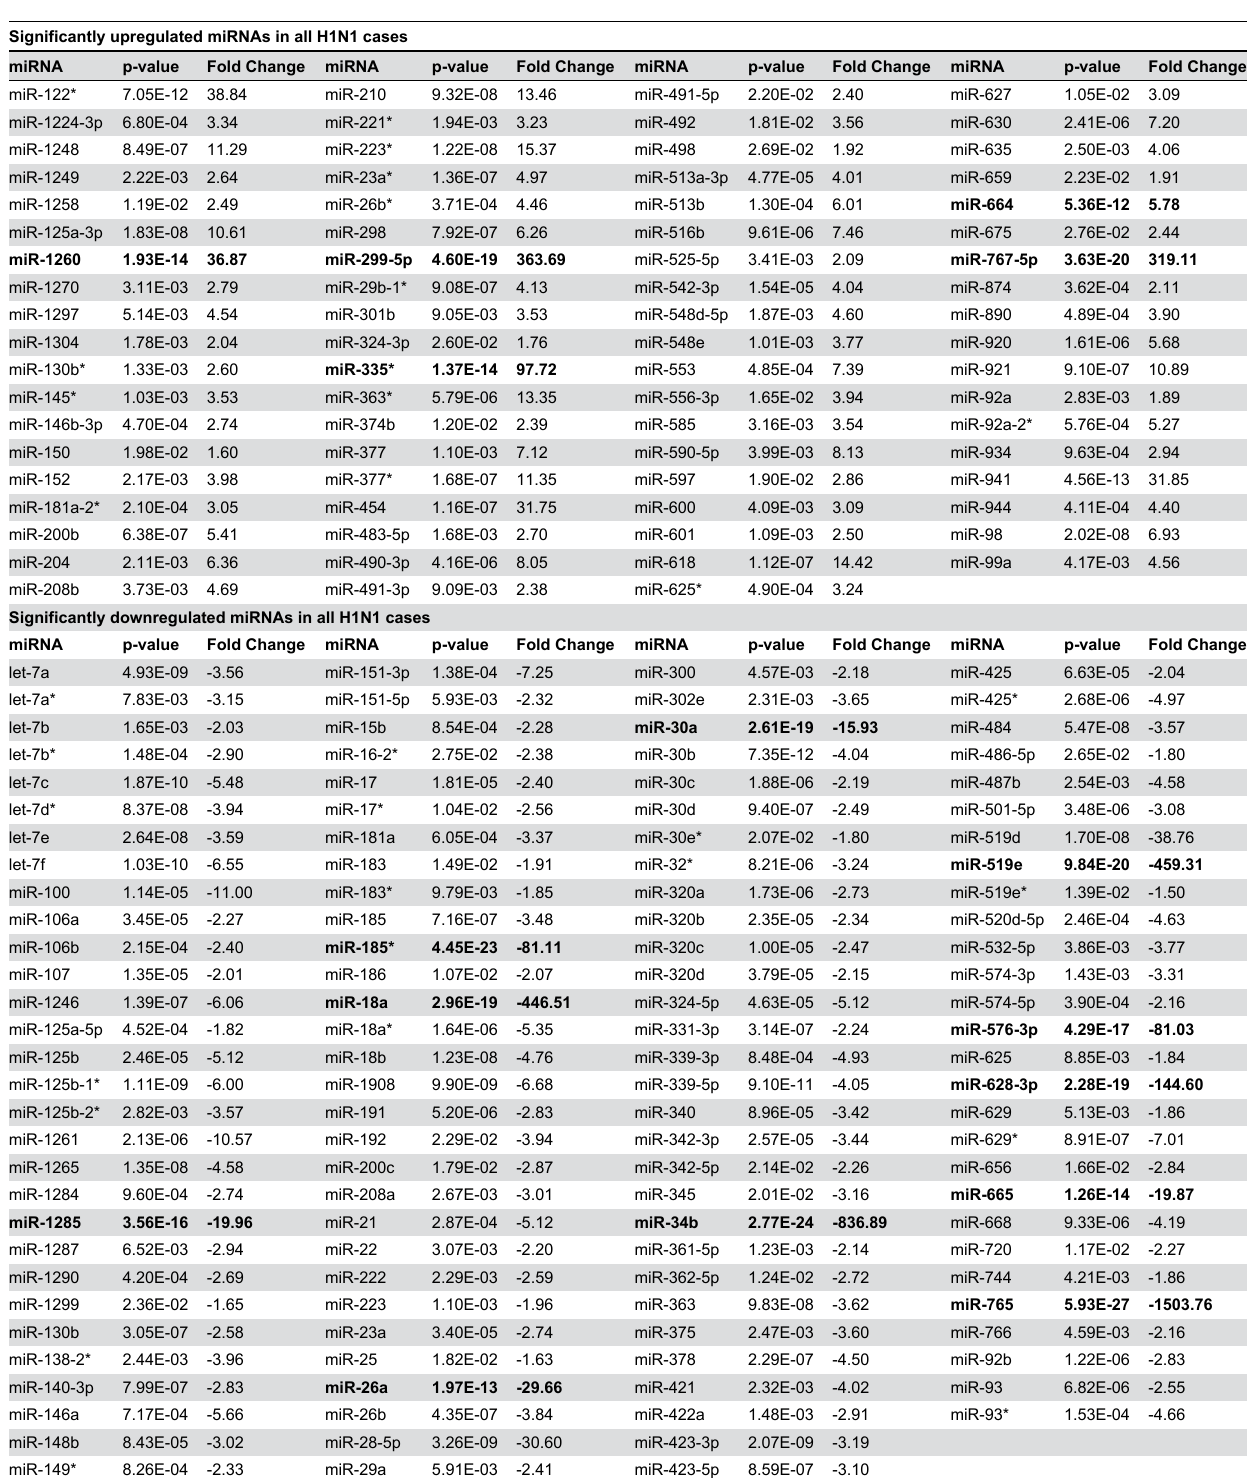
Table 1. Significantly dysregulated circulating miRNAs in H1N1